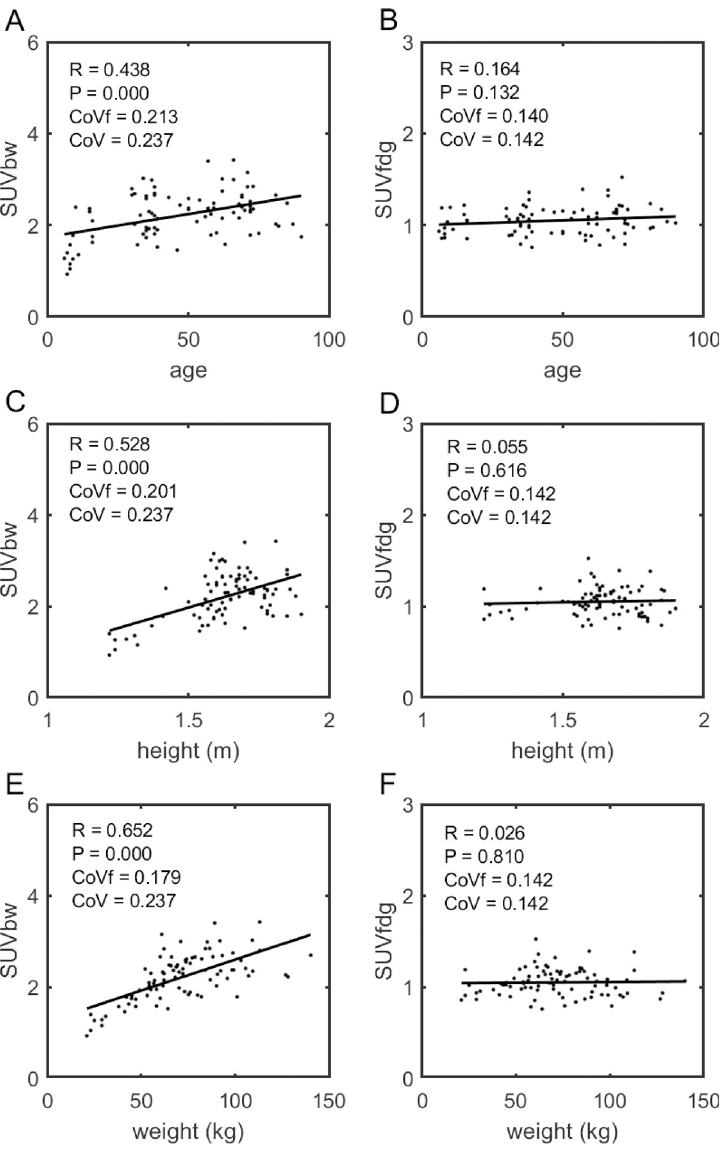
A, B), height (row C, D) and weight (row E,